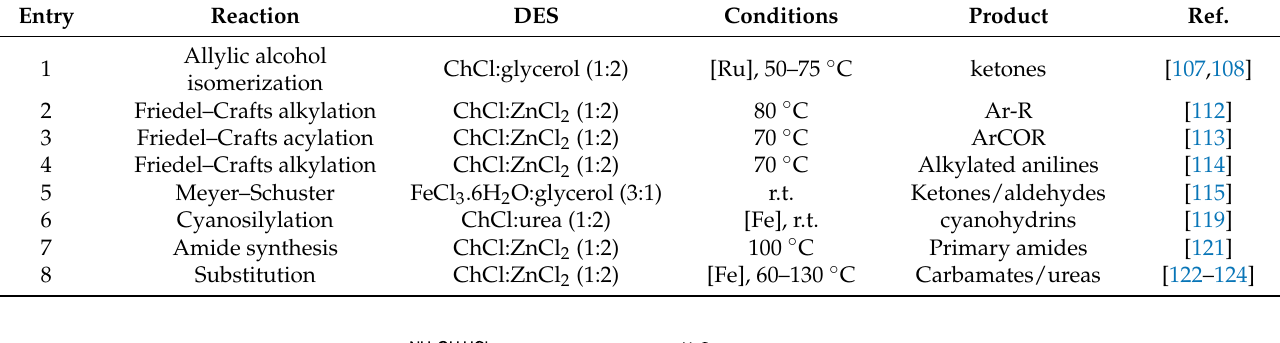
Figure 40. Cyanosilylation of aldehydes and epoxides. Table 6. Selected examples of miscellaneous reactions catalyzed by transition metals in DESs.